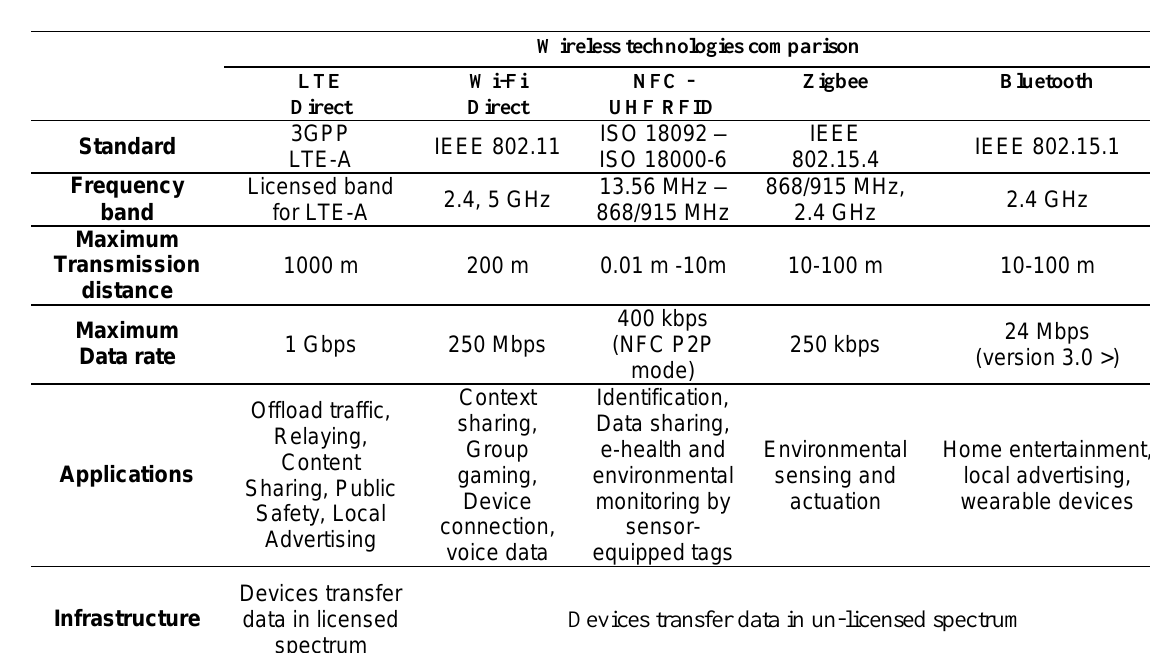
Table 1. Wireless D2D technologies